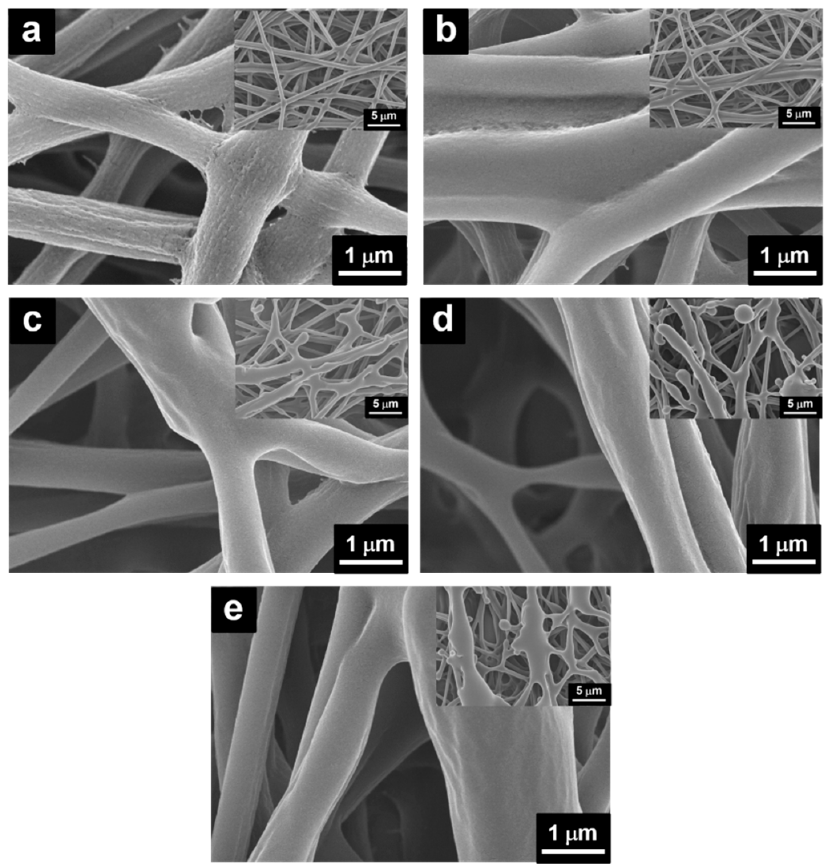
Figure 3. SEM images of PANI/P3TI/PMMA fibers treated by UV/ozone at different times, ( a ) 0 min, ( b ) 10 min, ( c ) 20 min, ( d ) 30 min, and ( e ) 40 min.